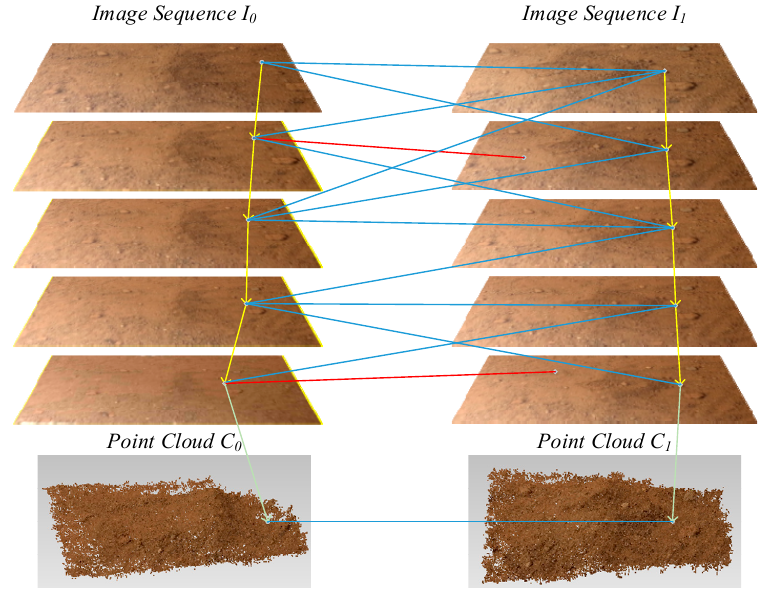
Figure 5. Registration of reconstructed point clouds in the collection area.